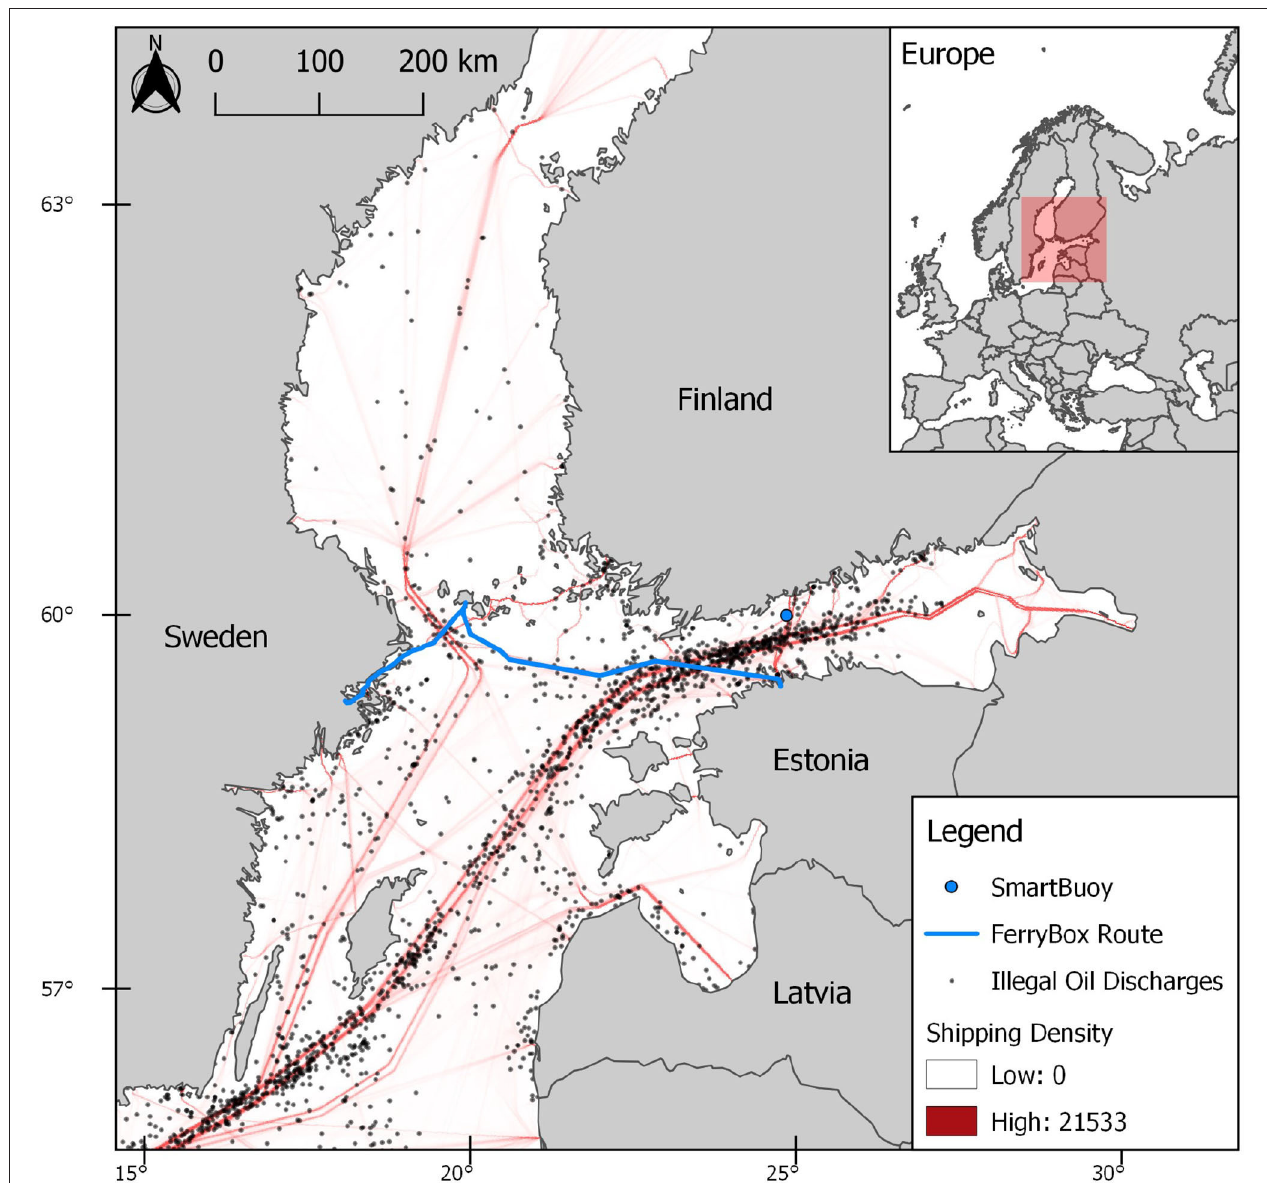
FIGURE 3 | FerryBox line and SmartBuoy mooring location in the Baltic Sea. Points of information describing the location and size of illegal oil discharges observed during aerial surveillance flights by HELCOM Contracting Parties during 1998–2017 (HELCOM, 2018b). Shipping density (defined as the number of ships crossing a 1 × 1 km grid cell) of all IMO (International Maritime Organization) registered ships operating in the Baltic Sea in 2016 (HELCOM,